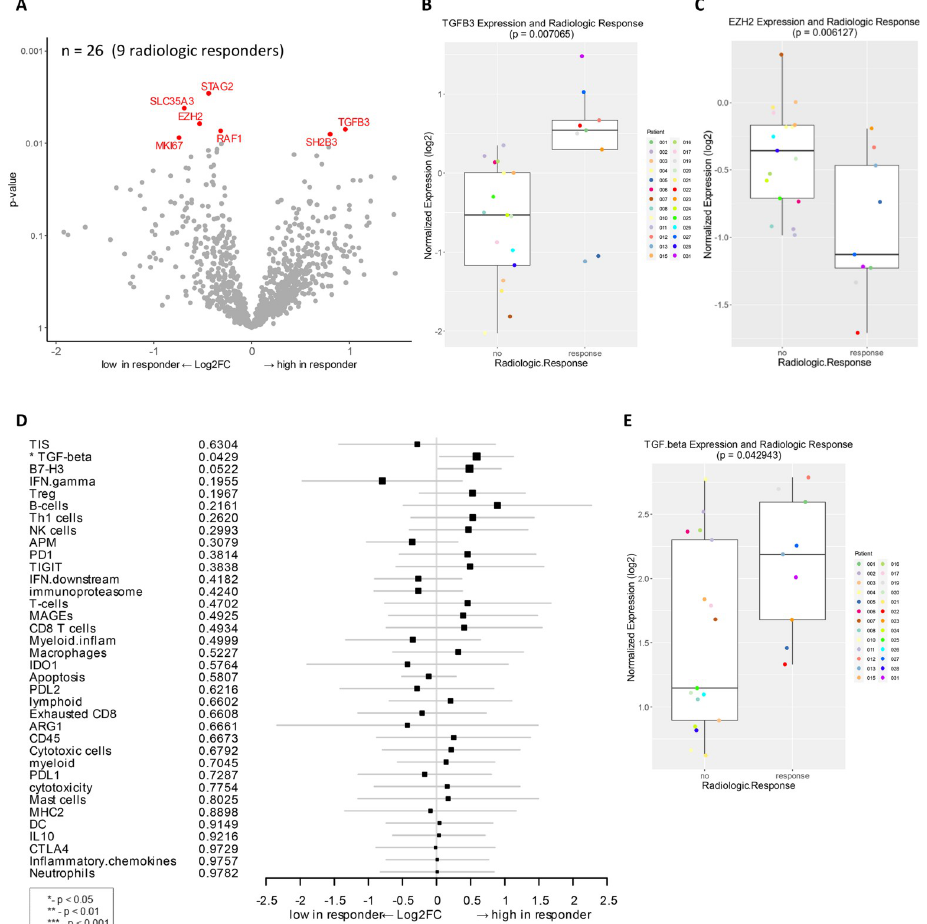
Fig 2. Genes and signatures associated with radiologic response in patients treated with combination immunotherapy of HDI and ipilimumab as a neoadjuvant therapy. A ) Volcano plot of unadjusted p -value vs. log2-fold change of the differential expression in patients who demonstrated radiologic response (unadjusted p < 0.01). Among 27 evaluable patients, 26 samples (9 radiologic responders) were available for analysis. B ) Boxplot of TGFB3 expression and radiologic response. C ) Boxplot of EZH2 expression and radiologic response. D ) Forest plot of difference of gene signature scores between low expression and high expression in radiologic responders. The position of the squared dots denotes the difference of score, and the size denotes the statistical significance. The horizontal lines are the Wald-type confidence intervals. The � sign denotes the significance of p -value ( < 0.05 � ). E ) Boxplot of TGF- beta signature score and radiologic